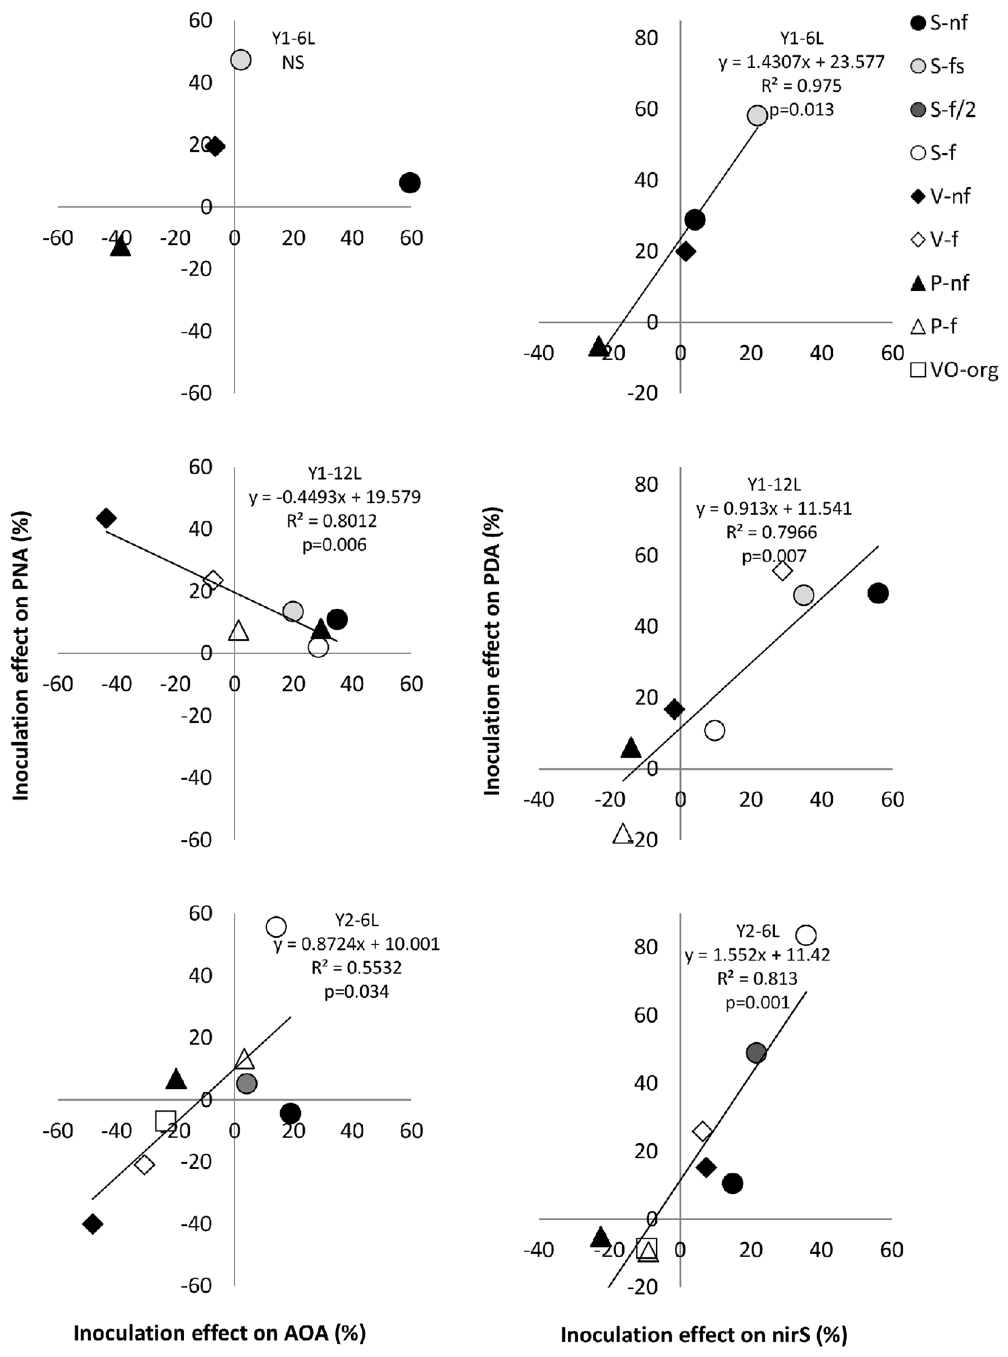
Figure 1. Relationship between the inoculation effects on (de)nitrifiers activity and on (de)nitrifiers abundance. Relationship between (left) the inoculation effects on potential nitrification activity, PNA, and on the abundance of ammonia-oxidizing archaea, AOA; and (right) the inoculation effects on potential denitrification activity, PDA, and on the abundance of nirS -denitrifiers. For each variable, the effect of inoculation was expressed as: % inoculation effect = [(I)/NI − 1] * 100. Each point corresponds to the mean value observed for n = 5 plot pairs (i.e. with and without inoculation). Relationships are presented for (Top) the 6-leaves stage during year 1, Y1-6L, (Middle) the 12-leaves stage during year 1, Y1-12L, and (Bottom) the 6-leaves stage during year 2, Y2-6L. V, S and P refer to the Valley, Slope and Plateau sites, respectively; nf, f, fs and f/2 refer to not fertilized, fertilized, fertilized at sowing and reduced fertilization, respectively. VO-org refers to Valley site